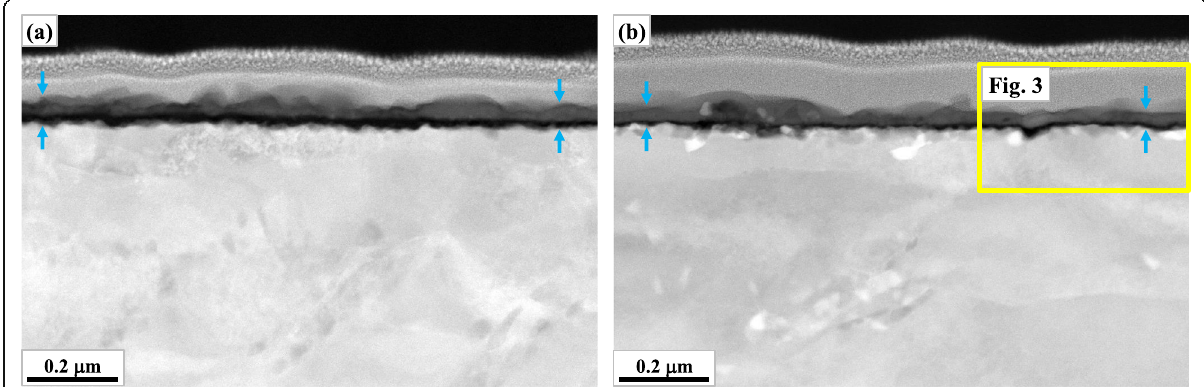
Fig. 4 Microstructures around the scales after 30 min of oxidation (STEI-DF): a W0, b W5 (the scale region is indicated by the arrows and the area within the solid box corresponds to a part of Fig. 3)